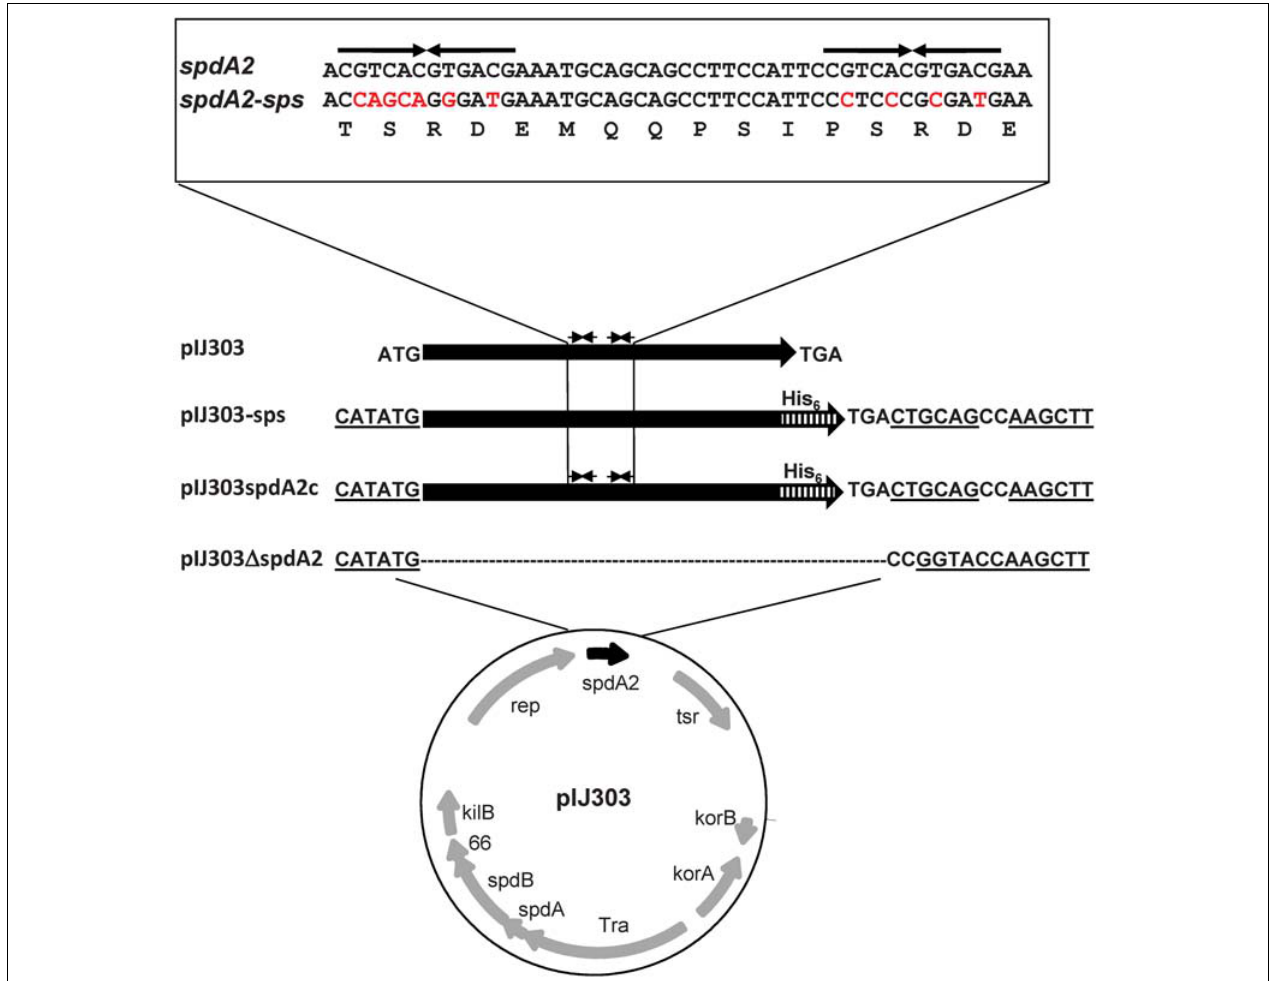
FIGURE 3 | Schematic maps of pIJ303 derivatives used to elucidate the function of spdA2 . The spdA homolog spdA2 (black arrow) of plasmid pIJ303 lies downstream of rep . In pIJ303 (cid:2) spdA2, spdA2 was replaced (see Materials and Methods) by a linker sequence containing restriction sites (underlined). The NdeI site is coincident with the original spdA2 start codon.